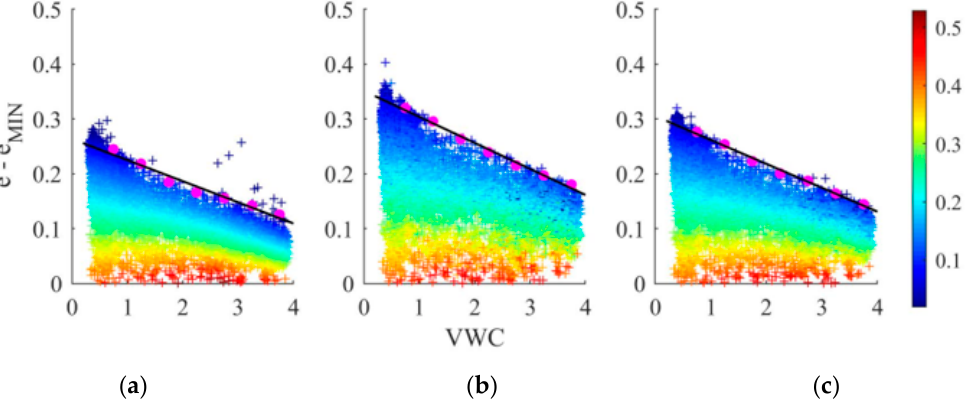
Figure 6. Difference between maximum and minimum of surface emissivity for vertical ( a ), horizontal ( b ) and combined vertical and horizontal ( c ) polarization at different VWC levels based on the descending SMAP dataset. The color of ‘+’ indicates the change of SSM. The pink circles represent e MAX − e MIN calculated by each VWC interval. The black solid line is the fitted linear relationship between e MAX − e MIN and VWC. Table 1. Fitted linear relationships between VWC and e MIN ( e MAX − e MIN ), and corresponding fitted parameters ( R 2 , RMSE—root mean squared error) derived from SMAP ascending and descending L3 SSM datasets for an agricultural area in northeast China from 2016–2018. Orbit Pol.